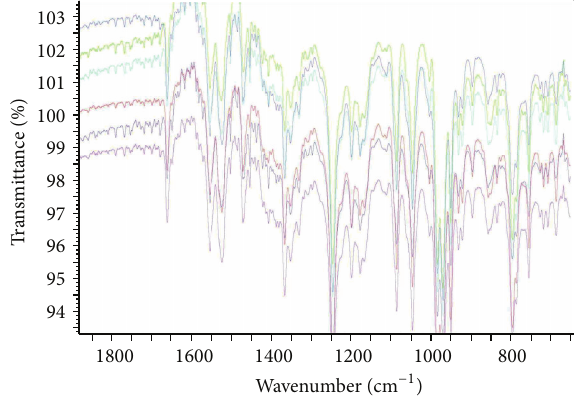
Figure 8: HPLC profile of unirradiated daunorubicin.